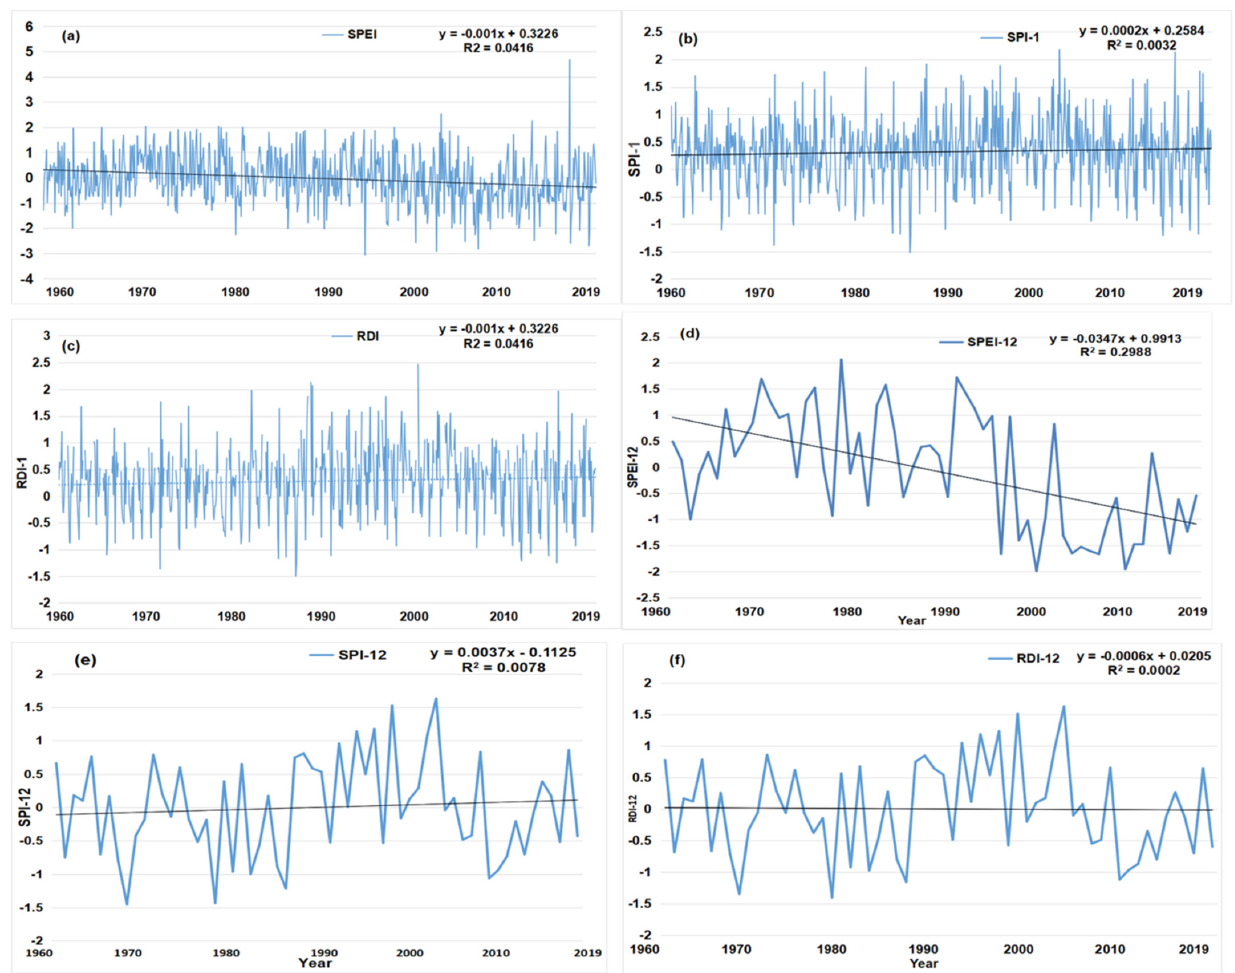
Figure 7. Turpan region drought indices time scale drought variation. ( a – c ) Monthly scale. ( d – f ) Annual scale.